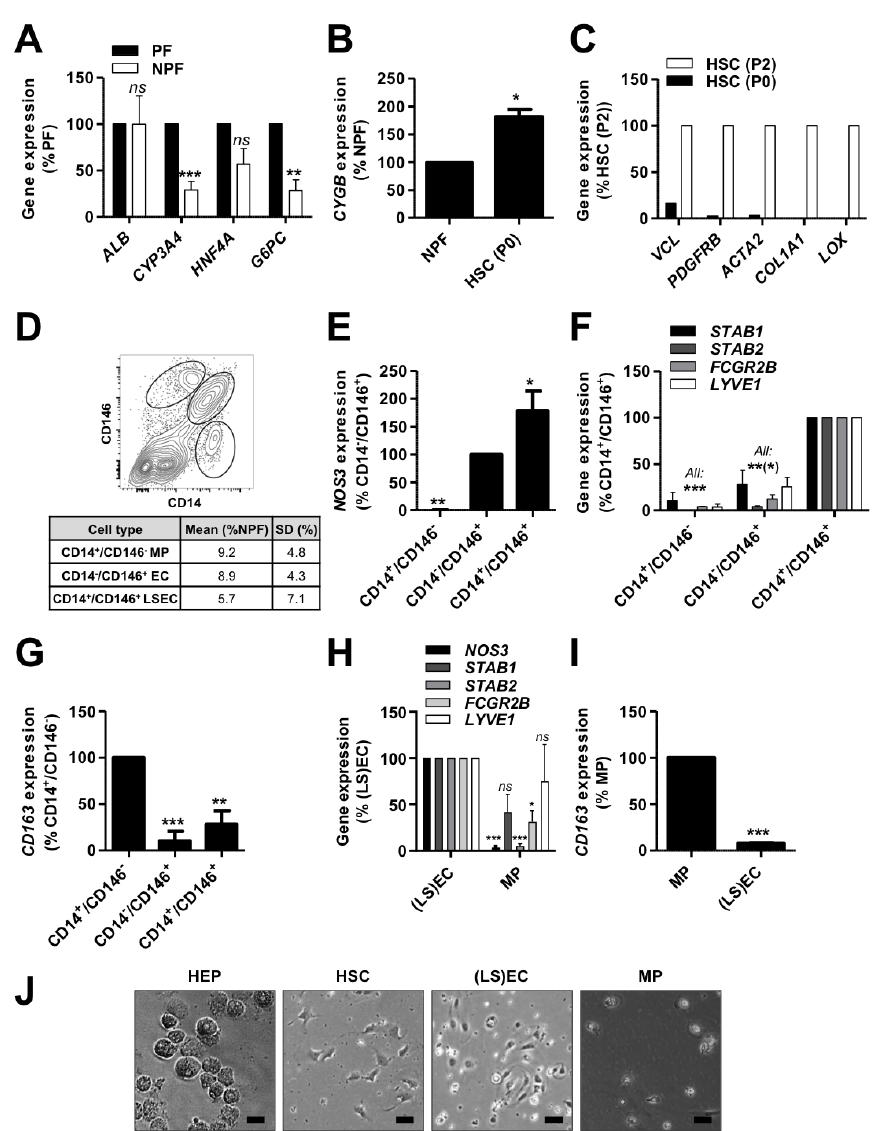
Figure 1. Isolation of human primary liver cells. Human primary liver cells were isolated from cryopreserved material of 4 donors (155, 156, 164 and 173). Gene expression was evaluated by qPCR ( A ) in hepatocytes (HEPs, n = 4), ( B ) in hepatic stellate cells (HSCs) just after isolation (P0, n = 3) and ( C ) after 2 passages on tissue culture plastic (P2, n = 2) for representative markers. ( D ) Representative flow cytometry dot plot (upper panel) and average yields after non-parenchymal fraction (NPF) FACS according to CD146 and CD14 expression. ( E – G ) Gene expression was evaluated by qPCR in CD14 + CD146 − macrophages (MPs), CD14 − CD146 + endothelial cells (ECs), CD14 + CD146 + liver sinusoidal ECs (LSECs) and CD14 − CD146 − other cells for representative markers ( n = 3). ( H , I ) After magnetic beads-activated cell sorting (MACS) for (i) CD146 and (ii) CD14, gene expression was assessed by qPCR in CD146 + (LS)ECs and CD146 − CD14 + MPs for representative markers ( n = 3 − 4). ( J ) Representative pictures of freshly isolated cells (scale bar = 50 µ m). All: results were analyzed per donor and are expressed as percentage of expression in the indicated fraction (expected maximal expression), graphs show mean ± SEM, Student’s t -test ( A , B and H , I ) or one-way ANOVA with Dunnett’s post-hoc test ( E – G ), ns p > 0.05, * p < 0.05, ** p < 0.01, *** p < 0.005. ACTA2 : actin α 2, ALB : albumin, COL1A1 : collagen type 1 α 1 chain, CYGB : cytoglobin, CYP3A4 : cytochrome P450 3A4, FCGR2B : Fc γ receptor 2b, G6PC : glucose 6 phosphatase catalytic subunit, HNF4A : hepatocyte